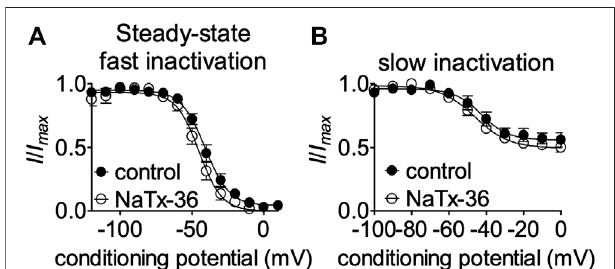
FIGURE 10 | Effects of DI S4 mutation R215G on steady-state fast inactivation and slow inactivation. (A,B) Representative steady-state fast inactivation and slow inactivation curves before and after 100 nM NaTx36 application to ND7/23 cells transfected with OtNa V 1.8 DI S4 fi rst GC R215G mutant channels. Cells were pretreated with 500 nM TTX to block TTX-sensitive sodium channels. All Na + currents were normalized to the maximum amplitude of control peak current. (A) Steady-state fast inactivation wasmeasured by astandard double-pulse protocol in which sodium currents were elicited by a 20-ms depolarizing potential of +30 mV following a 500-ms prepulse at voltages ranging from − 120 to +10 mV. 100 nM NaTx36 did not affect steady-state fast inactivation of the R215G mutant channels (control, n = 8; NaTx36, n = 5). (B) Steady-state slow inactivation was measured with 5 s pre-pulses ranging from − 130 to +10 mV, followed by 10 ms pulses to − 80 mV to allow recovery from fast inactivation followed by a 20-ms depolarizing potential of +30 mV. 100 nM NaTx36 did not affect steady-state fast inactivation of the R215G mutant channels (control, n = 5 cells; NaTx36, n = 4